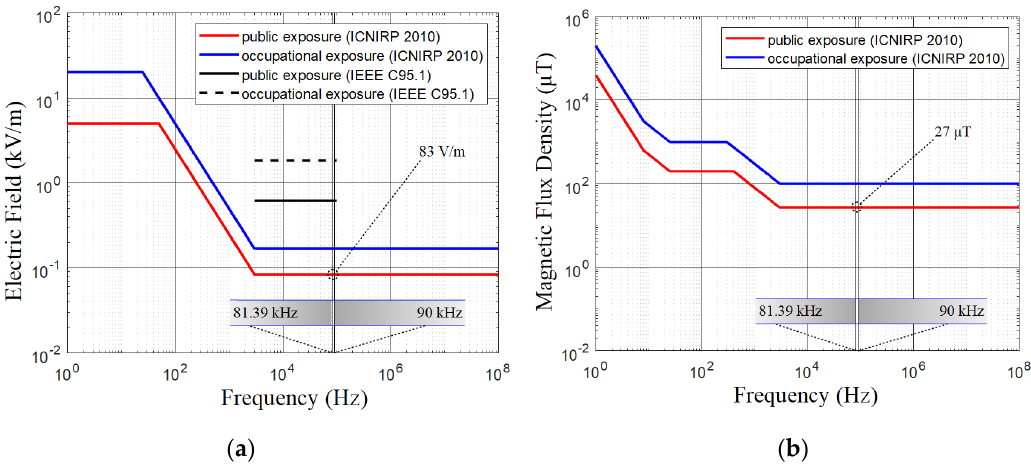
Figure 1. Reference level for exposure to time-varying electric ( a ) and magnetic ( b ) fields [15,16].